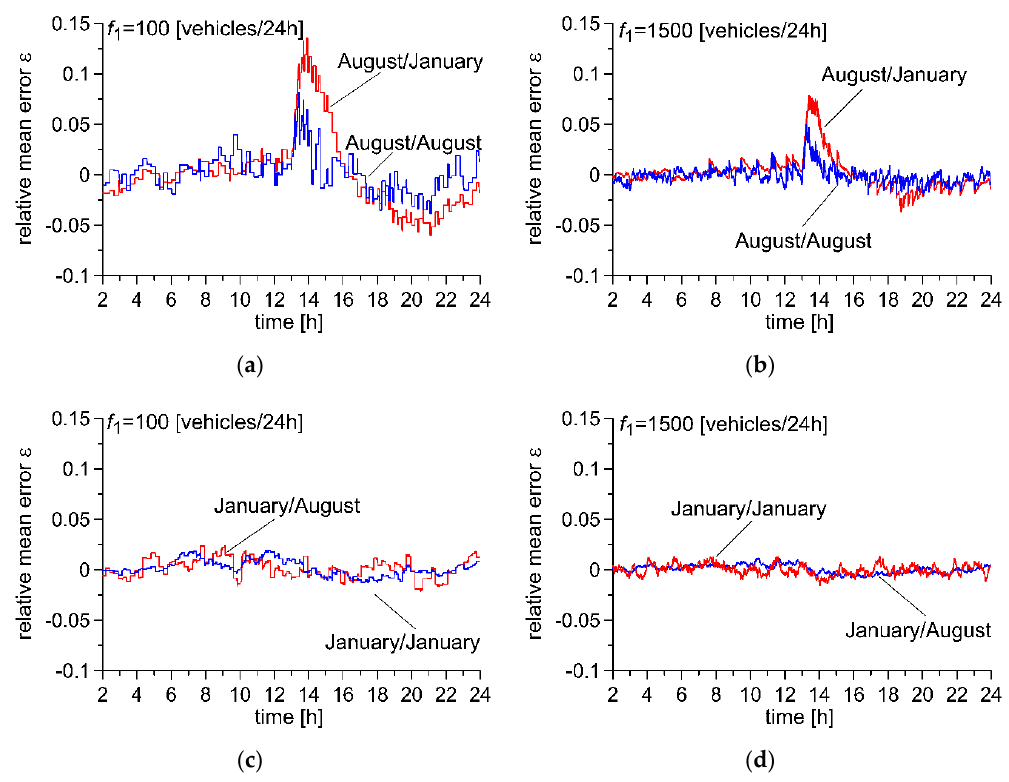
Figure 9. Comparison of precision of WIM systems optimised for various temperature fluctuation ranges. ( a ) f1 = 100 [vehicles/24h], temperature changes occurring in August, ( b ) f1 = 1500 [vehicles/24h], temperature changes occurring in August, ( c ) f1 = 100 [vehicles/24h], temperature changes occurring in January, ( d ) f1 = 1500 [vehicles/24h], temperature changes occurring in January.